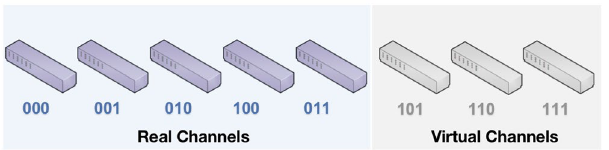
Figure 1. Extension of number of channel by adding virtual channels with five channels as an